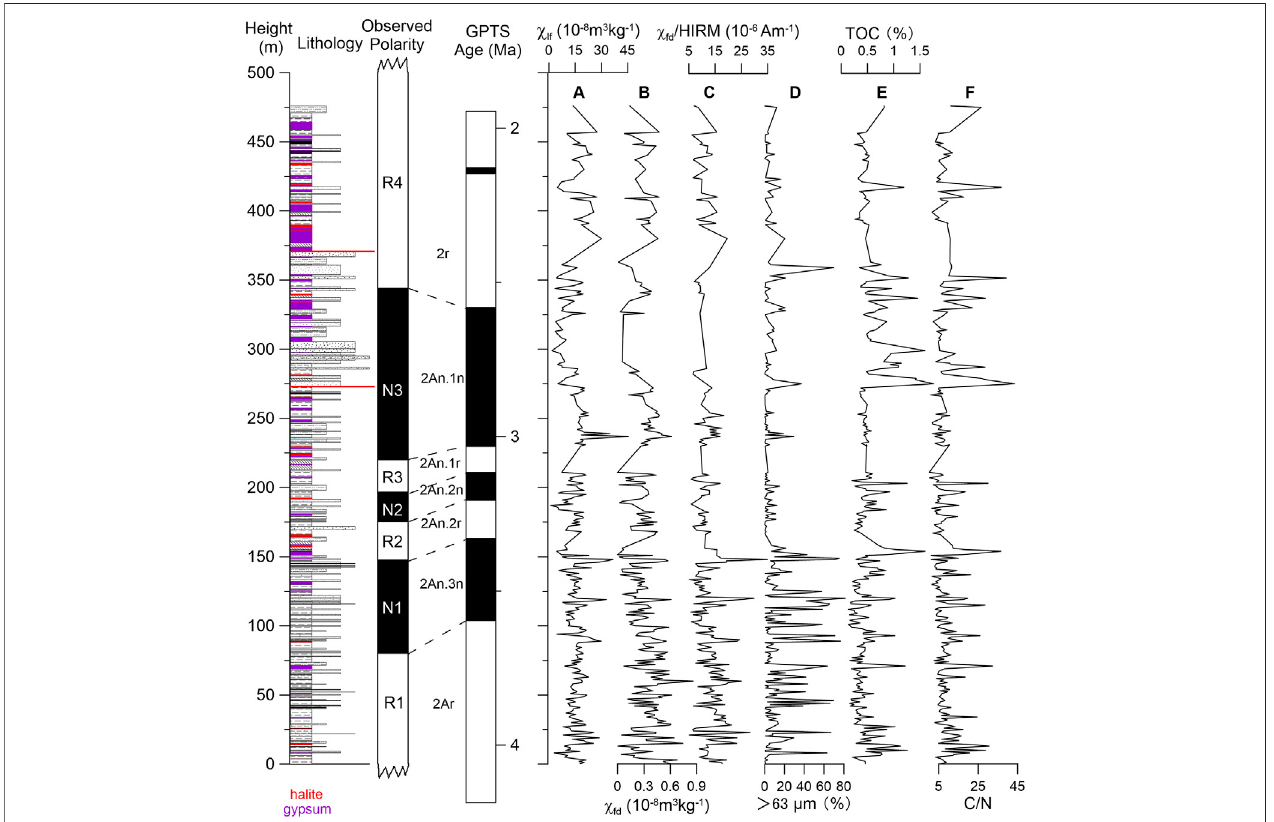
FIGURE3| PaleoenvironmentalproxyrecordsandcorrespondingstratigraphiccolumnoftheHuatugousectioninthewesternQaidamBasin,NETibetanPlateau. (A – C) The χ lf , χ fd ,and χ fd /HIRMrecords(Suetal.,2019a;Suetal.,2019b). (D) The > 63 μ mfractiongrainsizerecord(Suetal.,2019b). (E – F) TheTOCandC/Nrecords. LargerTOCvaluescorrespondtohigherC/Nratiovalues,suggestingterrestrialorganicmatterinput.ThemagnetostratigraphyoftheHuatugousectionwasderivedfrom Luo et al. (2018).